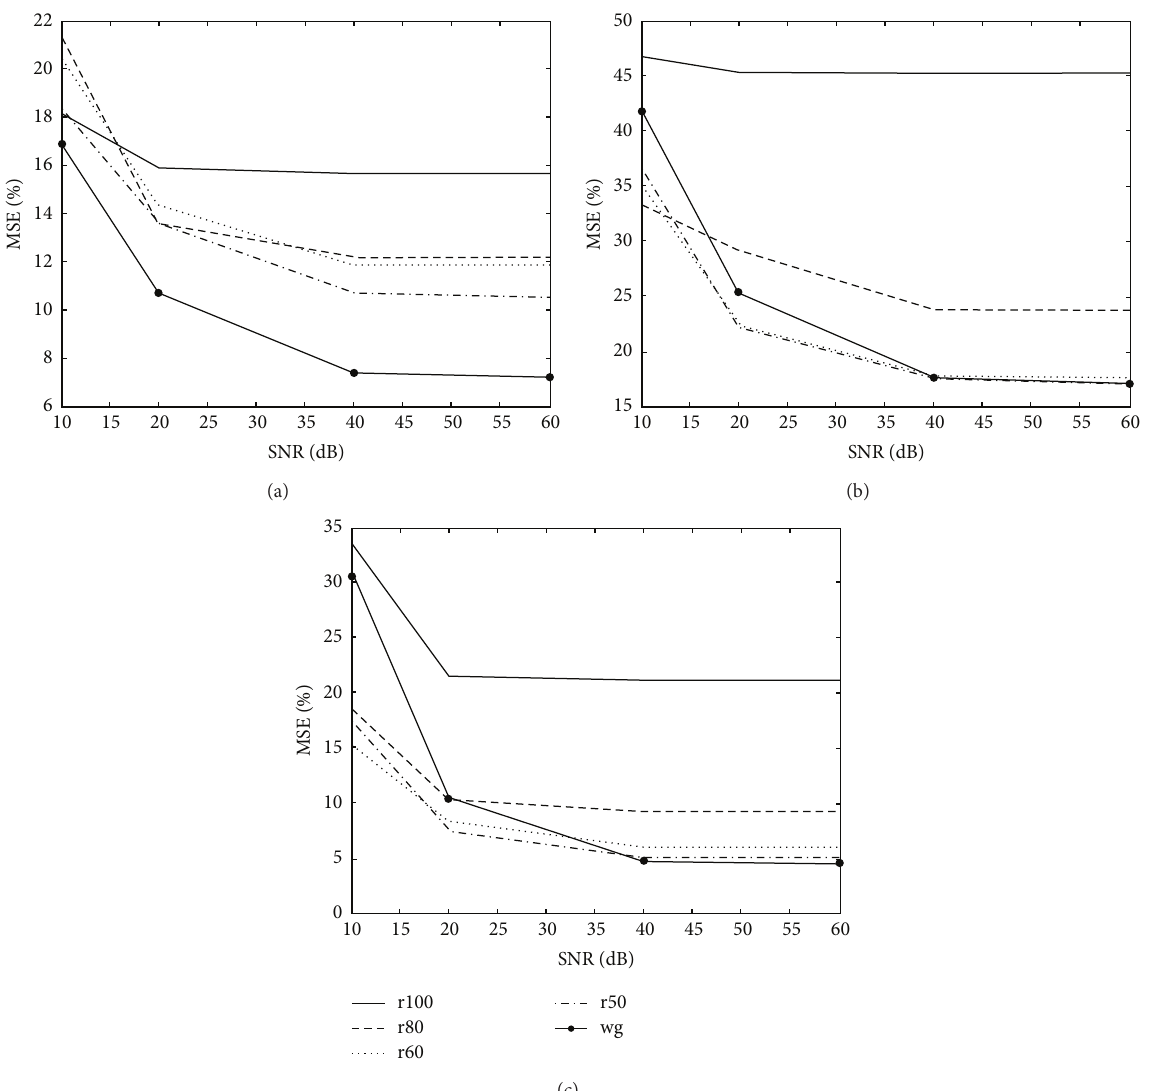
Figure 6: MSE of the different reconstructions. (a) Mostly fatty phantom. (b) Scattered fibroglandular phantom. (c) Very dense phantom. Each point of the MSE curves is obtained after averaging 20 different reconstructions with independent noise